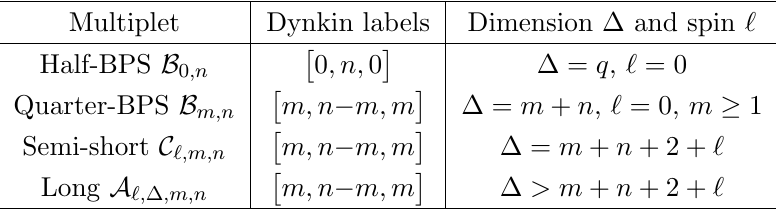
Table 1 . Supermultiplets which can appear in the four point function of half-BPS operators. we (cid:12)nd that they always appear with identical coe(cid:14)cients as contributions to the chiral part f in eq. (3.9). These together organize into superconformal blocks with double-trace